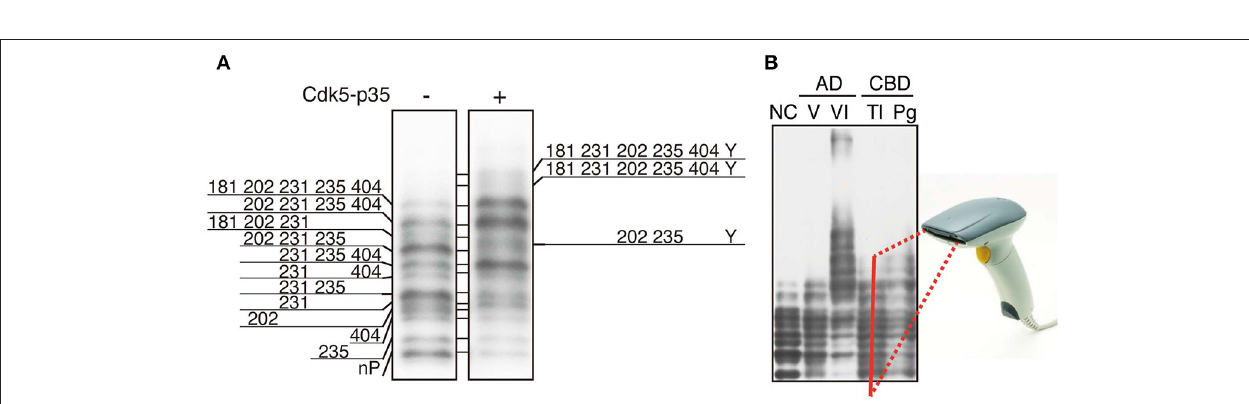
Frontiers in Neuroscience |